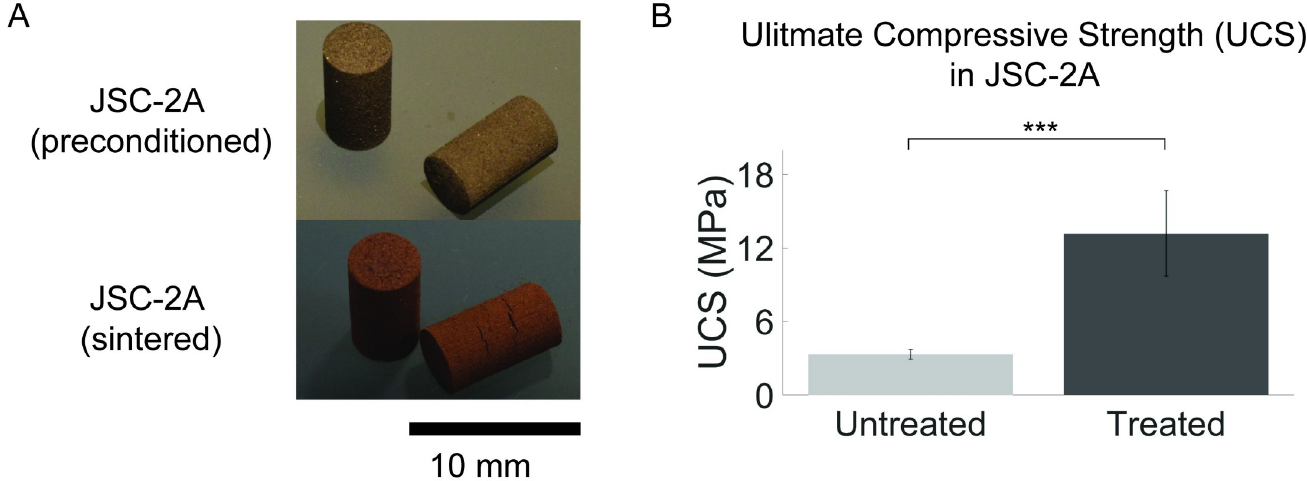
Fig 6. Lithography-based ceramic manufacturing (LCM) prints of JSC-2A regolith-based materials. (A) Lithography-based ceramic manufacturing of the regolith simulant JSC-2A (B) The ultimate compressive strength (UCS) of untreated (n = 9) and the bacterially treated and magnetically extracted material (n = 5). Error bars are displayed as standard deviation (Student’s t-test: N.s. > 0.05; � � 0.05; �� � 0.01; ��� � 0.001).